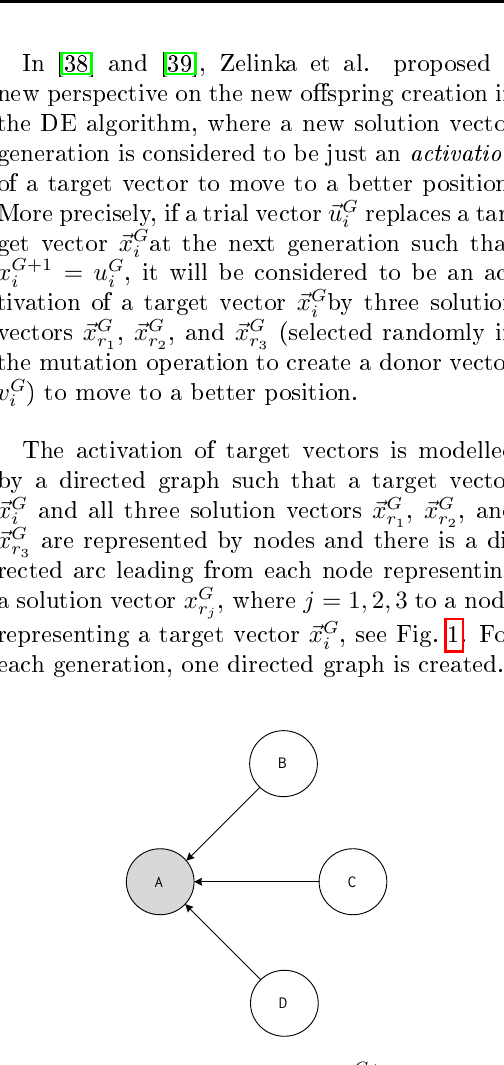
i (represented by , (cid:126)x G r and 1 2